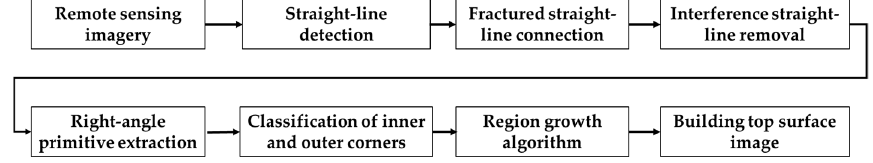
Figure 2. The flowchart of building detection based on rectangular approximation.